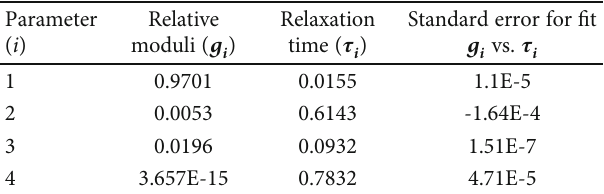
Table 2: Parameters of Prony series approximation calculated by Equation (1) based on G ′ and G ″ values for the adhesive cream.